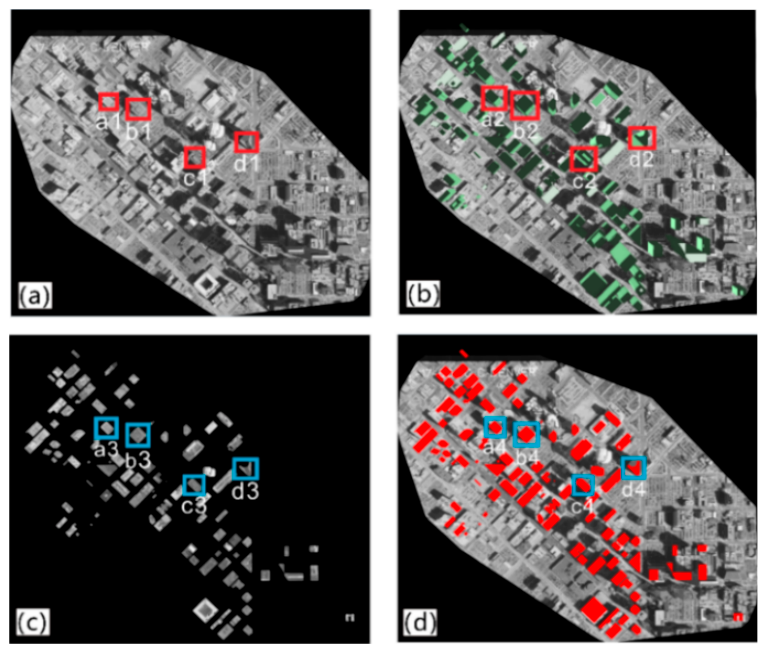
Figure 27. Analysis of T 2 OM generation results. ( a ) output orthophoto, ( b ) orthophoto superimposed on the DBM, ( c ) extracted roof texture, ( d ) red area used to represent the superpixels generated with the DBM. Where a1-a4 are four regions with the same geographical position in ( a – d ); b1–b4 are four regions with the same geographical position in ( a – d ); c1–c4 are four regions with the same geographical position in ( a – d ); d1–d4 are four regions with the same geographical position in ( a – d ). Table 12. 3D coordinate values before and after encoding.